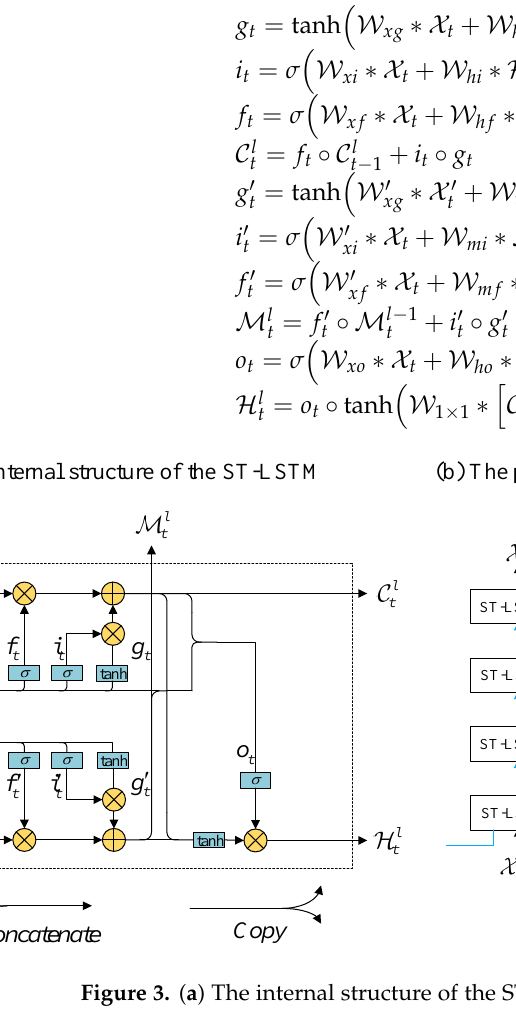
memory state M t while preserving part of the gate structures in ConvLSTM. M t propa- gates in a zigzag pattern throughout the network. l indicates at which layer of the network the corresponding state is located. The input gate i t , forget gate f t and input-modulation gate g t are the original gates in ConvLSTM. They control the information flow across the memory state C t . The functions of i (cid:48) , f (cid:48) and g (cid:48) are the same as above, but they control the t t t information flow across the memory state M t . The output gate o t is an improvement on